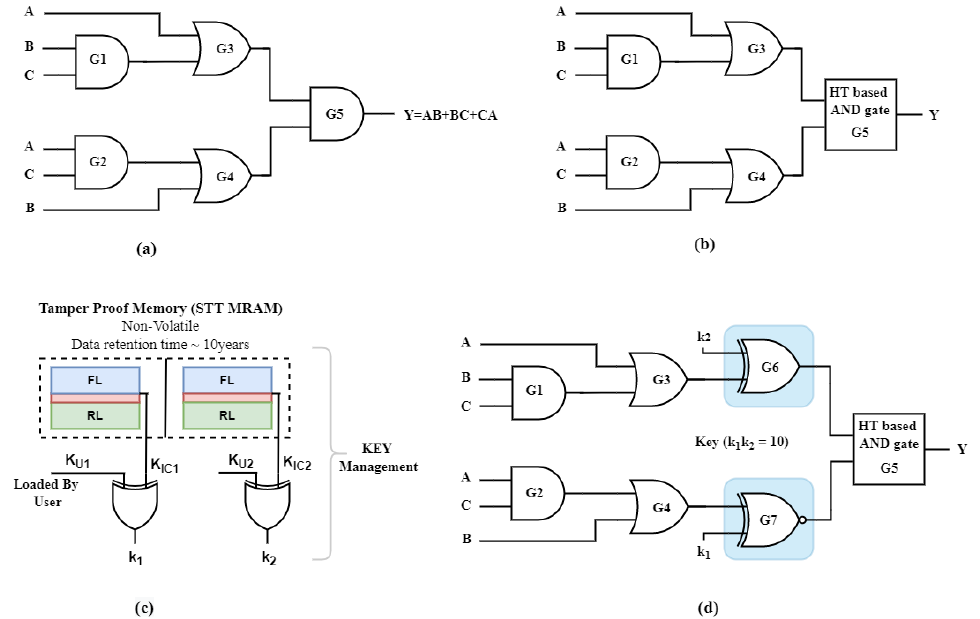
Figure 4. ( a ) Unlocked netlist with Y = AB + BC + CA. ( b ) G5 replaced with MTJ-based hardware Trojan block. ( c ) Key management for logic locking block. ( d ) Locked netlist with MTJ-based hardware Trojan